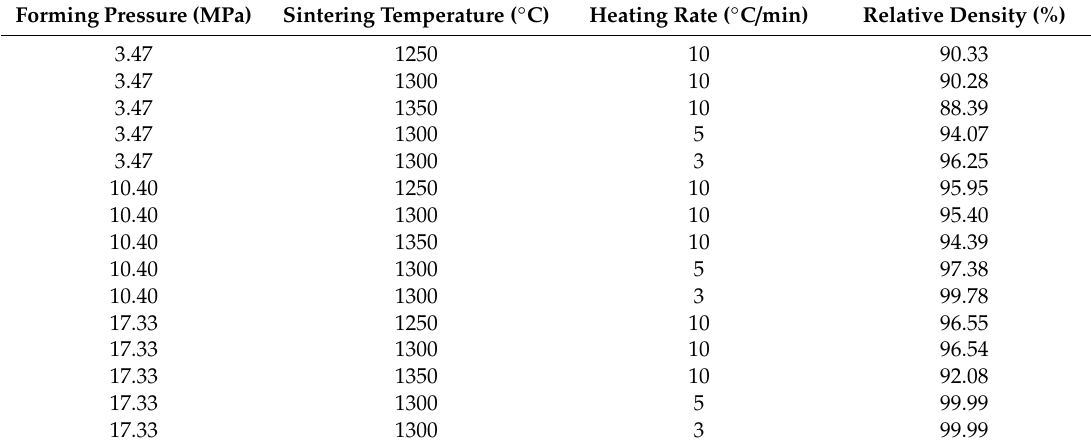
Density of the sintered PZT ceramics according to the forming pressure and the sintering